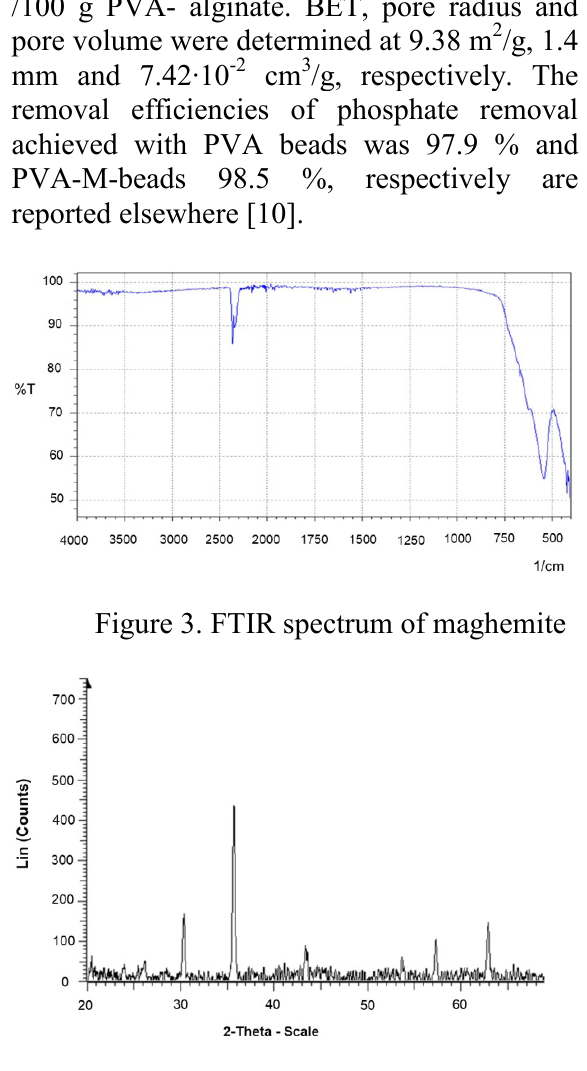
Table 1. After 240 min the efficiency of PO